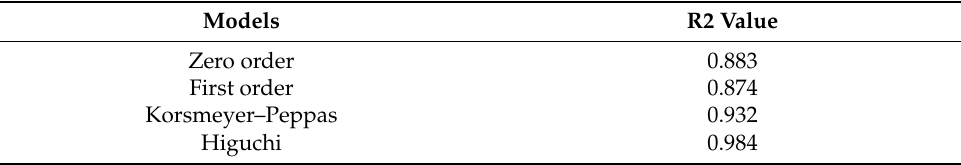
Figure 4. Overlay of X-ray diffractograms of A (FA), B (CBZ), and C (CBZ-FA complex). Table 1. Kinetics of in vitro